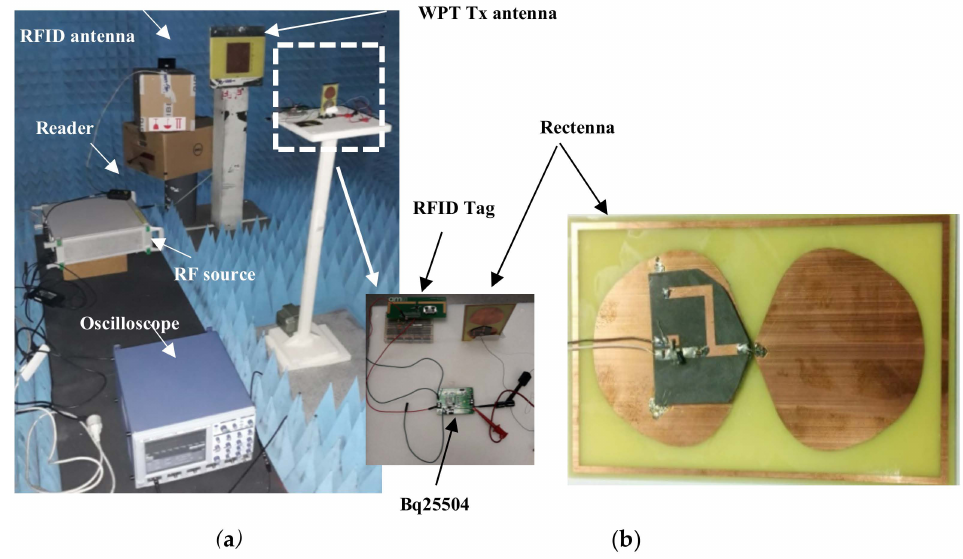
Figure 2. Photographs of ( a ) the experimental setup and ( b ) the node rectenna. Tx: